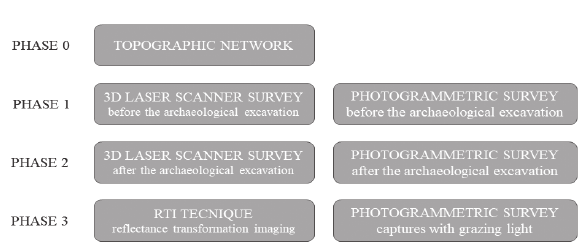
Figure 10. Workflow data acquisition and processing.